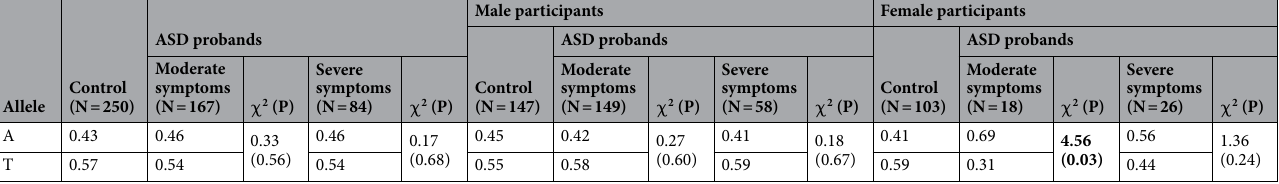
Table 1. Population based comparative analysis on rs3810651 allelic frequency. N.B: Statistically significant difference is presented in bold.